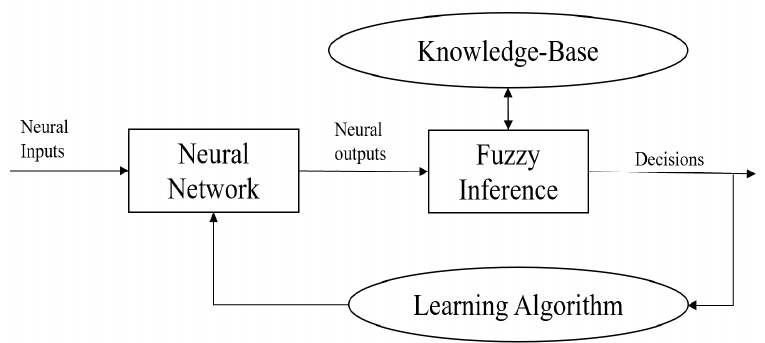
Figure 4. The block diagram of the Neural-Fuzzy system.